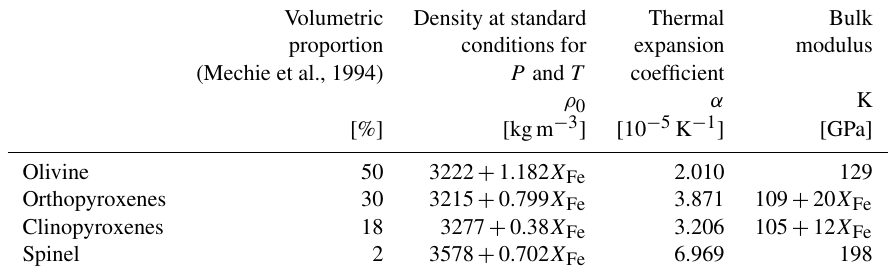
Table D1. Volumetric proportions of minerals and physical properties assumed to form mantle rock in the study area. Volumetric Density at